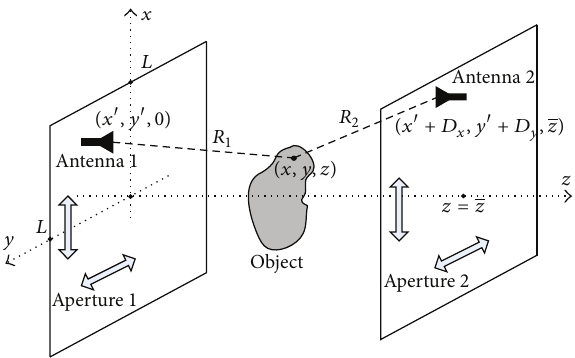
Figure 1: Microwave holography setup. The grey thick arrows show the directions of 2D